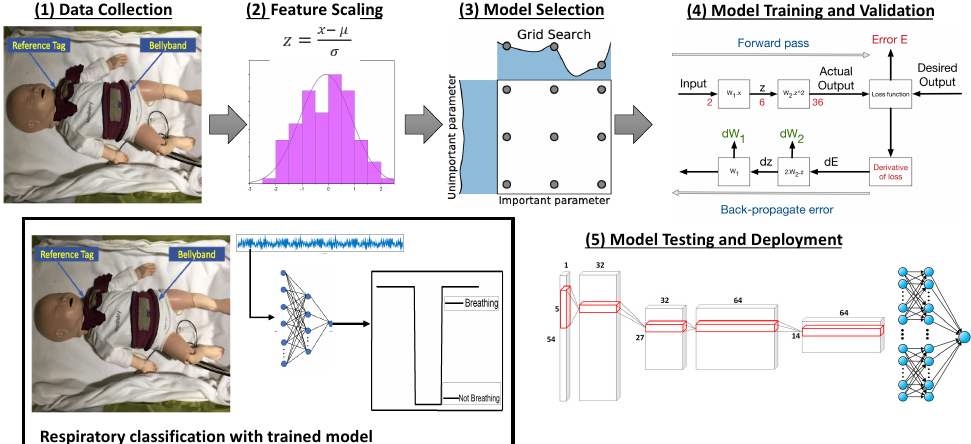
Figure 2. Design pipeline for respiratory classification using deep